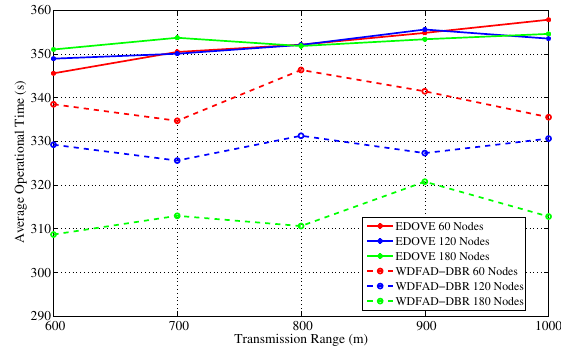
Figure 19. Average network operational time versus the transmission